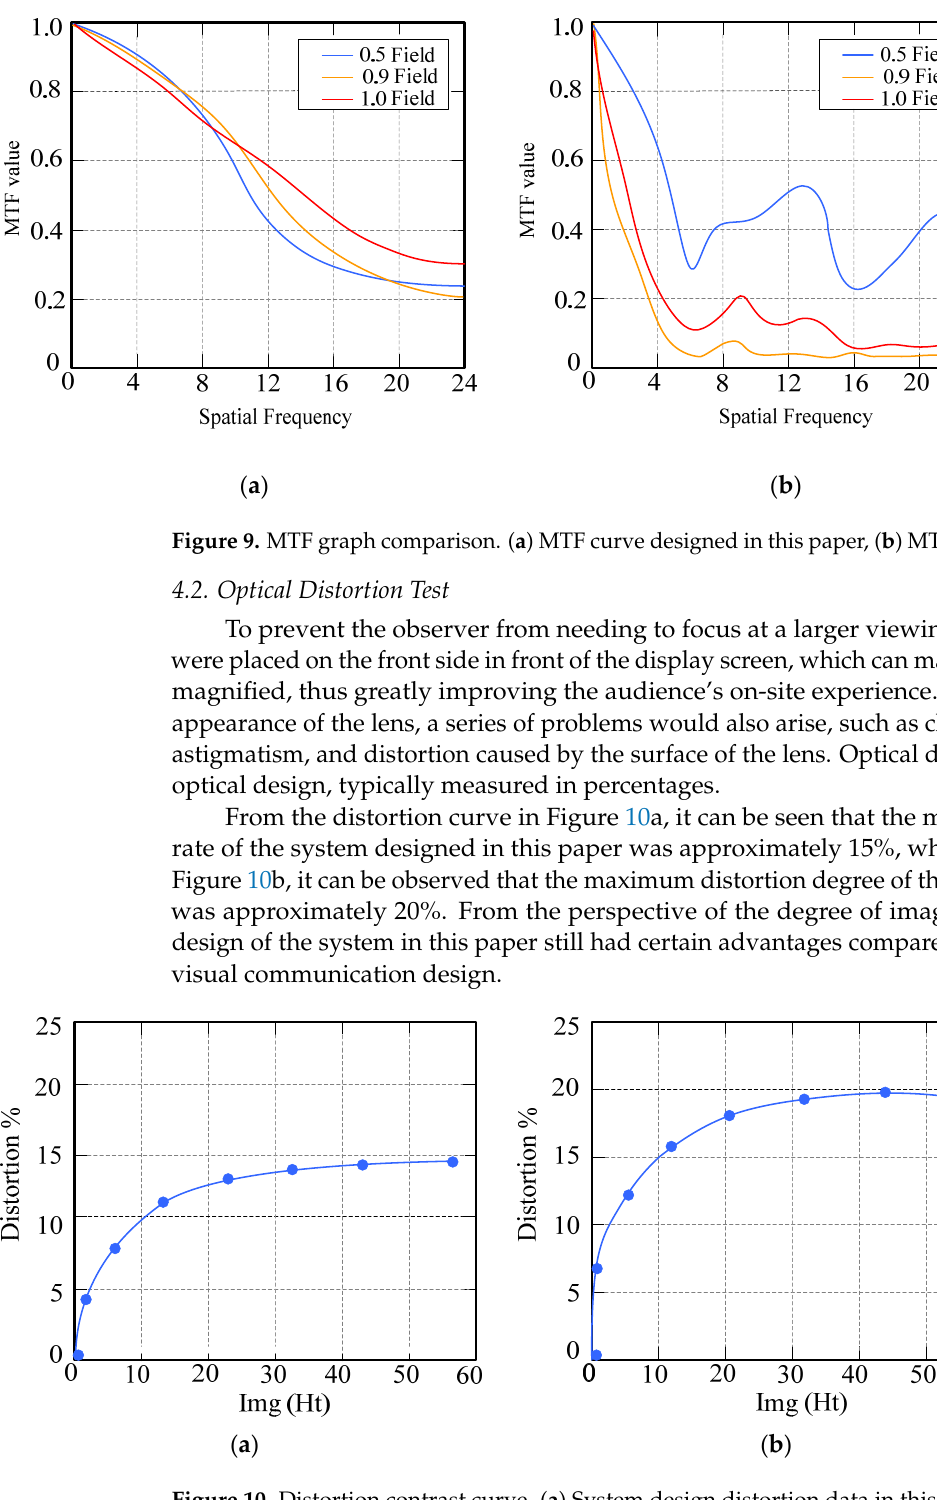
12 of 15 Figure 8. Focal length plan. 4. Visual Communication Optical System Test 4.1. Optical System Design When adjusted, the focal length of the lens changes over time, ensuring that viewers with different viewing angles see the same picture as the viewing angle. The system con-